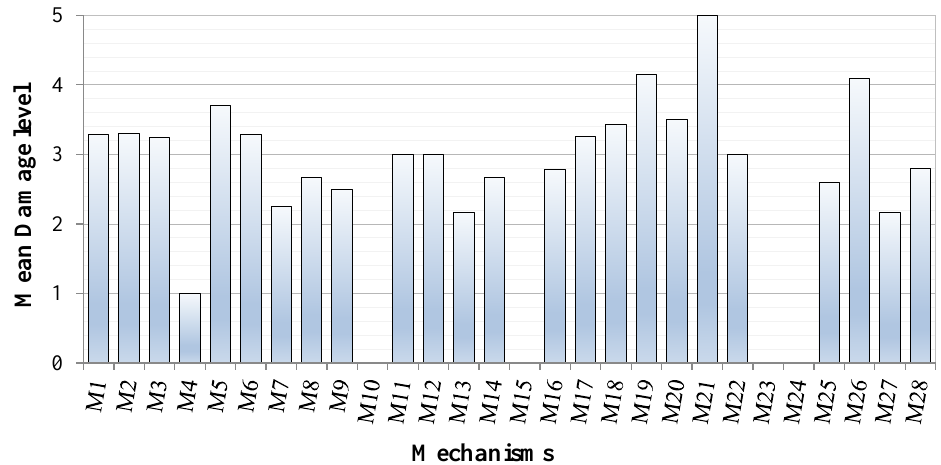
Figure 22. Mean damage levels of the mechanisms activated in the inspected churches.